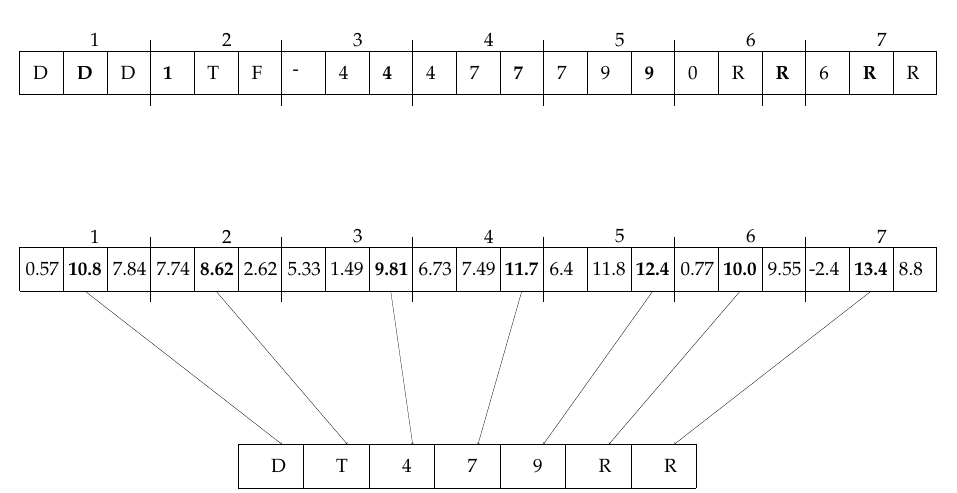
Figure 7. Classifications of overlapping slots and selection of characters for the final result.